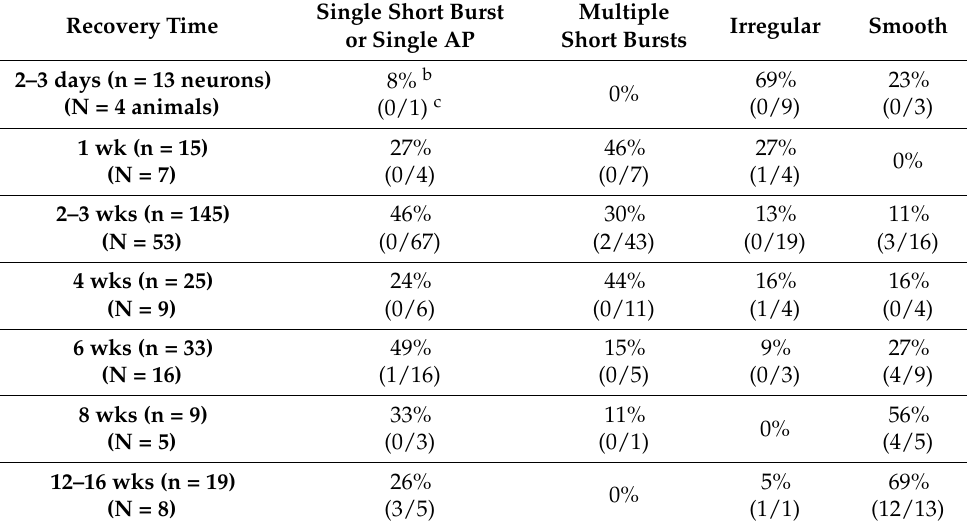
a—large, identified injured (right) RS neurons (see text and Figure 1B): M cells; I cells; B cells (Müller cells, see Figure 1A); some of the B cell from [28] and [30] were used for the present analysis. b—percentage of RS neurons with a particular firing pattern at intermediate current levels (see rationale in Section 3.3 of Results). c—fraction of RS neurons with a particular firing pattern that elicited orthodromic responses caudal to right spinal cord HTs at 10% BL (see SC2 in Figure 1B). Table 2. Firing Patterns of Different Large, Identified Injured RS Neurons a at 2–3 Week Recovery Times Following Right Spinal Cord HTs at 10% BL. Single Short Burst Multiple RS Neuron Irregular or Single AP Short Bursts